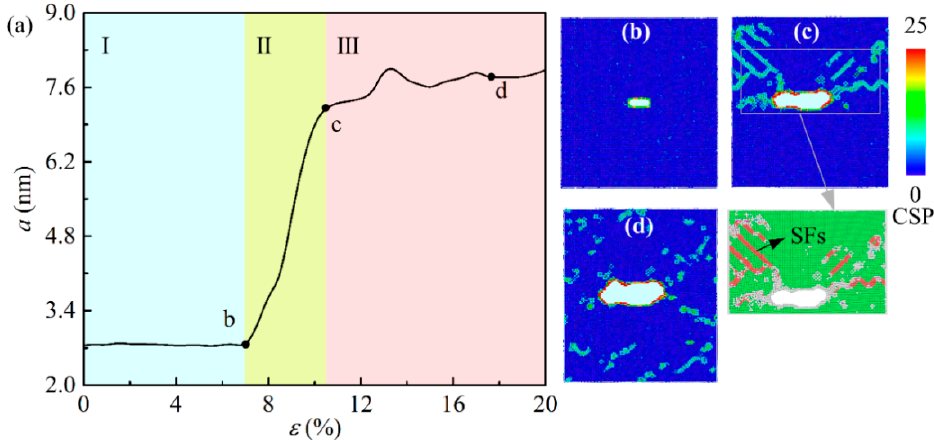
Figure 8. The relationship between crack length and strain curve under uniaxial tensile. ( b – d ) corresponds to the CSP atomic configuration diagram of the feature point in ( a ).